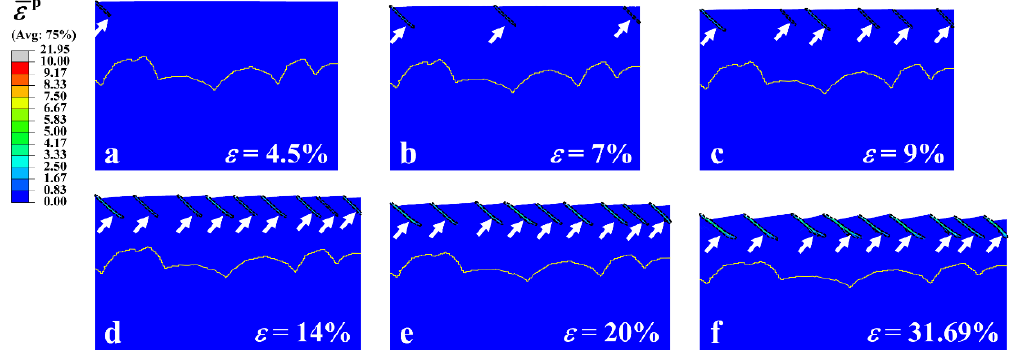
Figure 6. ( a – f ) Evolution of shear bands in the gradient Cu with applied strain ε . Regions with equivalent plastic strain ε p larger than 1 are shown by black dashed lines. Shear bands are indicated by white arrows. The yellow lines are dividing lines between the CG core and the GSL.